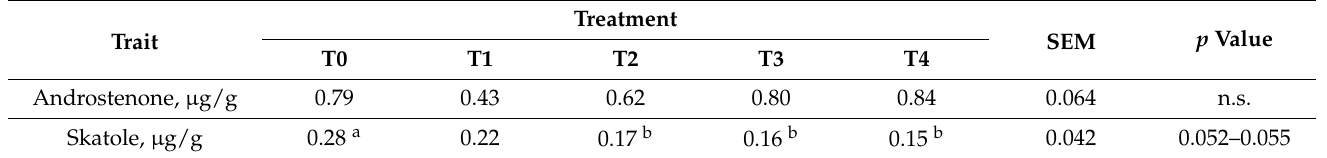
Table 3. Effect of tannin supplementation on androstenone and skatole accumulation in fatty tissue.